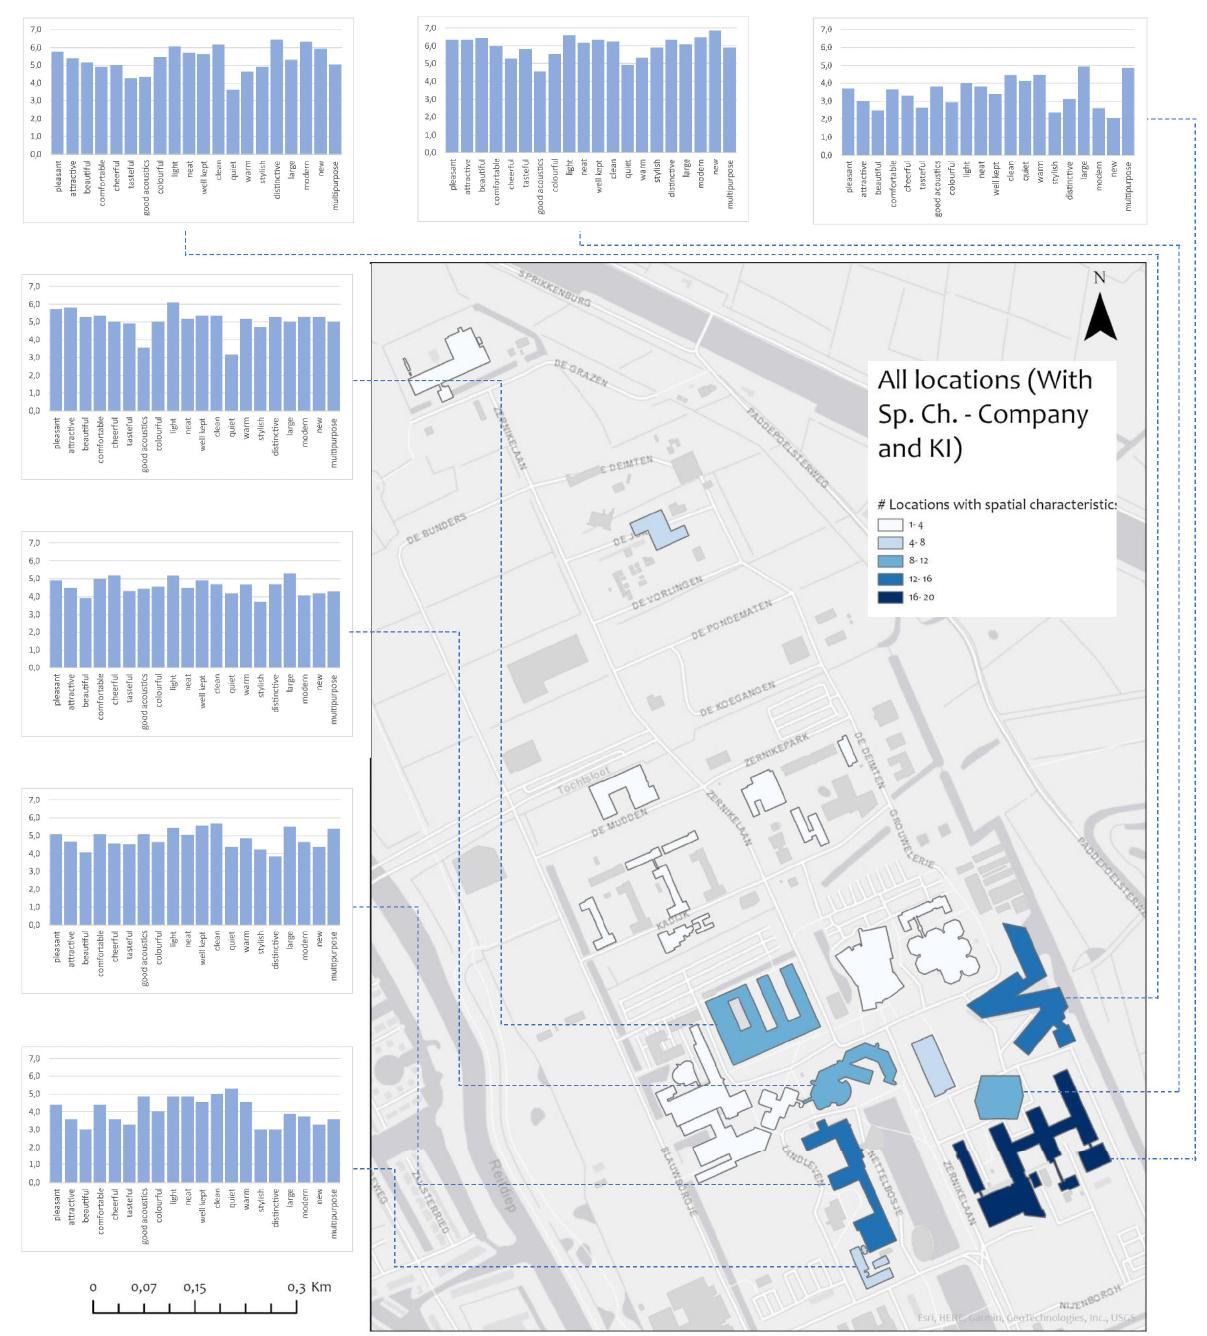
Figure A10. RUG campus—average building characteristics’ score for buildings with the highest number of indicated locations. # = ‘Number of’.